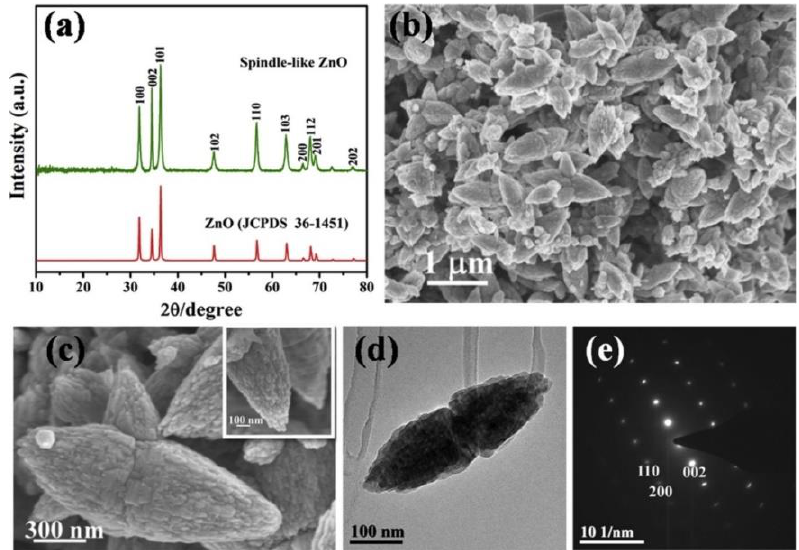
Figure 63. X-ray powder diffraction ( XRD) pattern ( a ), SEM ( b , c ), TEM ( d ) images and satisfactory selected area electron diffraction (SAED) pattern ( e ) of the as-prepared spindle-like ZnO. Products synthesised by microwave and ultrasonic wave combined method. Reprinted from [888], Copyright (2019), with permission from Elsevier [OR APPLICABLE SOCIETY COPYRIGHT OWNER]. All rights reserved. In order to re-use permission must be obtained from the rightsholder.